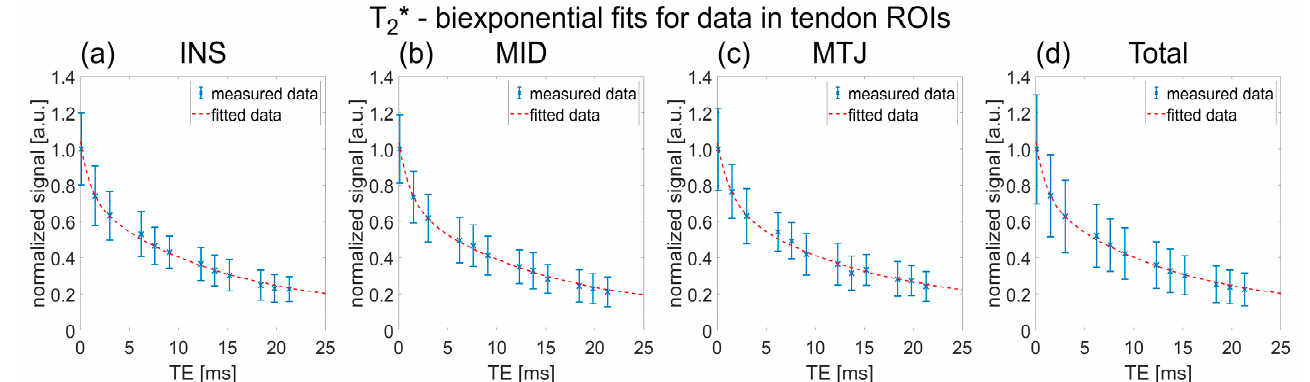
Figure 2. Data points and fitting results to determine 23 Na T 2 * relaxation times in the different AT ROIs of an exemplary healthy control. The corresponding parameter results were ( a ) 23 Na T 2s * = 1.0 ms, 23 Na T 2l * = 13.3 ms, p s = 32.7%, R 2 = 0.997, ( b ) 23 Na T 2s * = 1.2 ms, 23 Na T 2l * = 13.6 ms, p s = 34.9%, R 2 = 0.998, ( c ) 23 Na T 2s * = 1.4 ms, 23 Na T 2l * = 13.8 ms, p s = 35.7%, R 2 = 0.994 and ( d ) 23 Na T 2s * = 1.1 ms, 23 Na T 2l * = 13.3 ms, p s = 33.2%, R 2 = 0.998. Table 2. Parameter results for aTSC, 23 Na SNR and 1 H T 2 * in all ten healthy controls and the patient with Achilles tendinopathy in the different AT ROIs. Two different standard deviations were calculated: While “ ± ” indicates the absolute deviation between the mean values of the controls, the column “SD” displays the deviation between voxel values in the ROI of each control in percent. Controls Parameter ROI 23 Na SNR Parameter